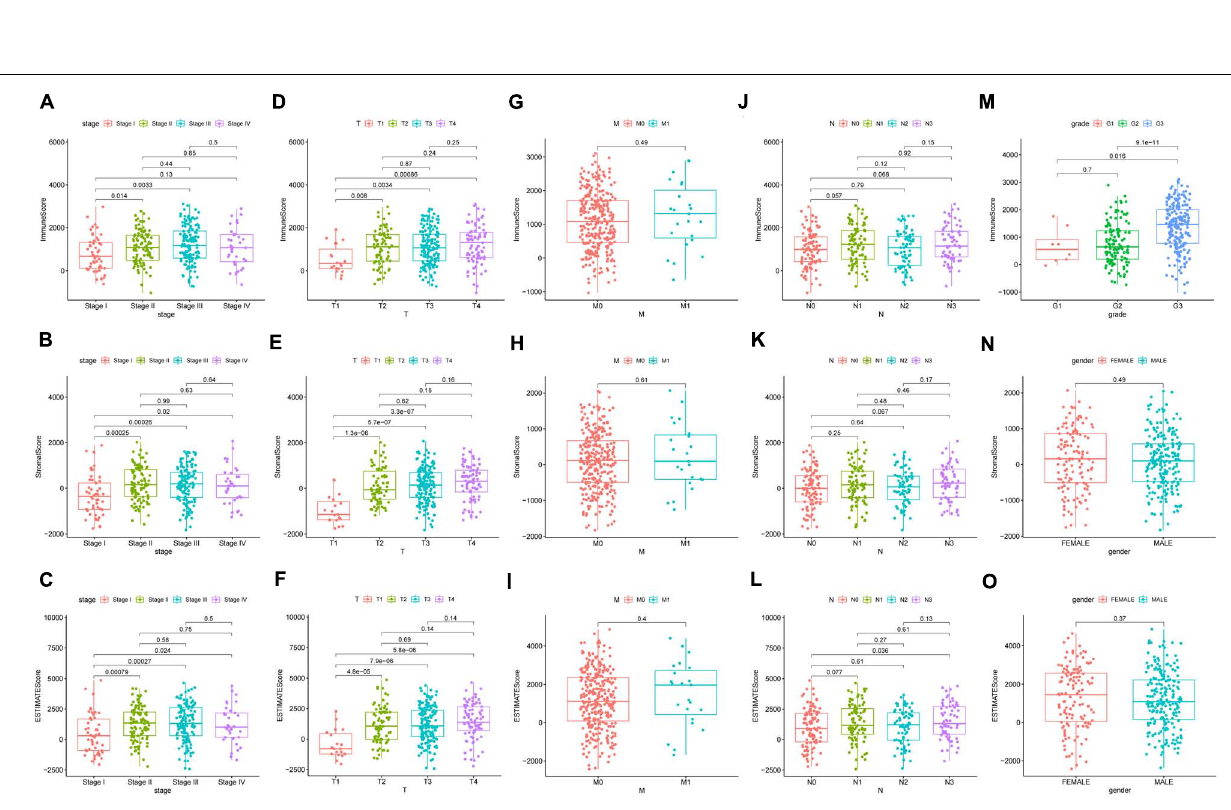
Frontiers in Cell and Developmental Biology |